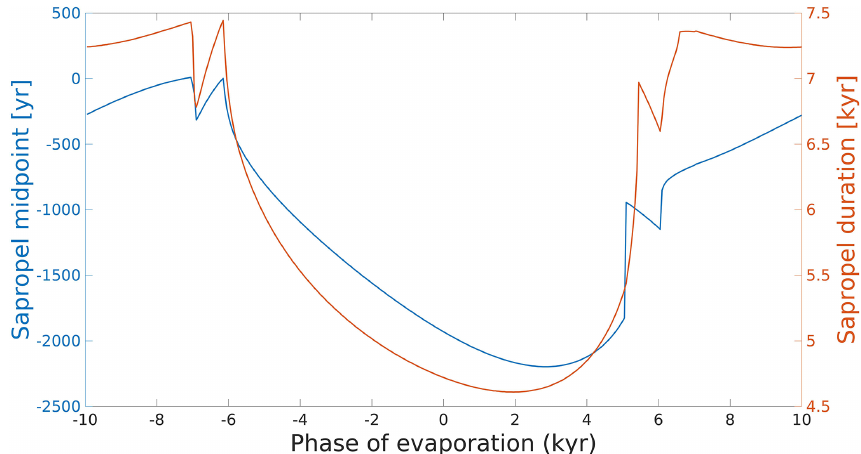
Figure 8. Sapropel duration (right axis) and the timing of the midpoint relative to the precession minimum (on the left axis) as a function of the phase of evaporation. Apart from the phase of evaporation, the model forcing is the same as the first run in Sect. 3.3.